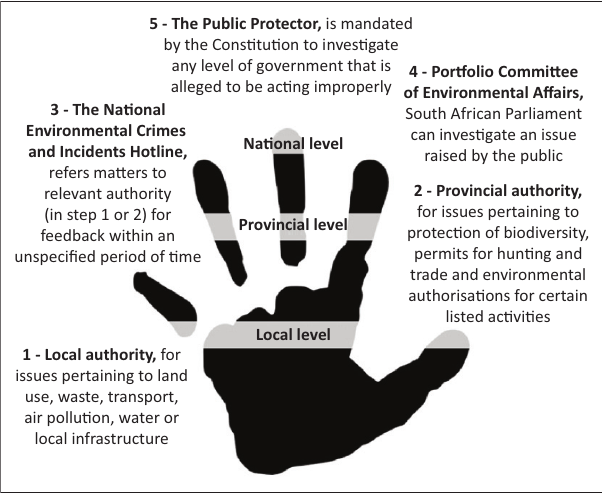
FIGURE 5: A diagrammatic summary of escalating an environmental problem to the three tiers of government (local, provincial and national) to reach a